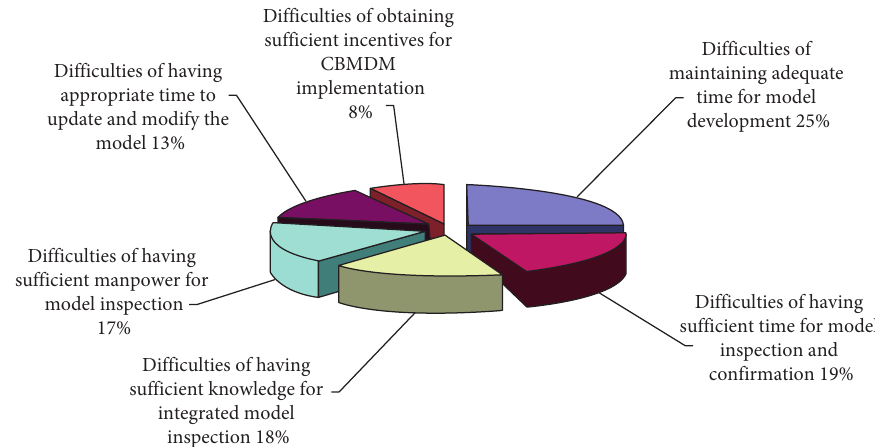
Figure 10: The major problems for CBMDM tasks in the case